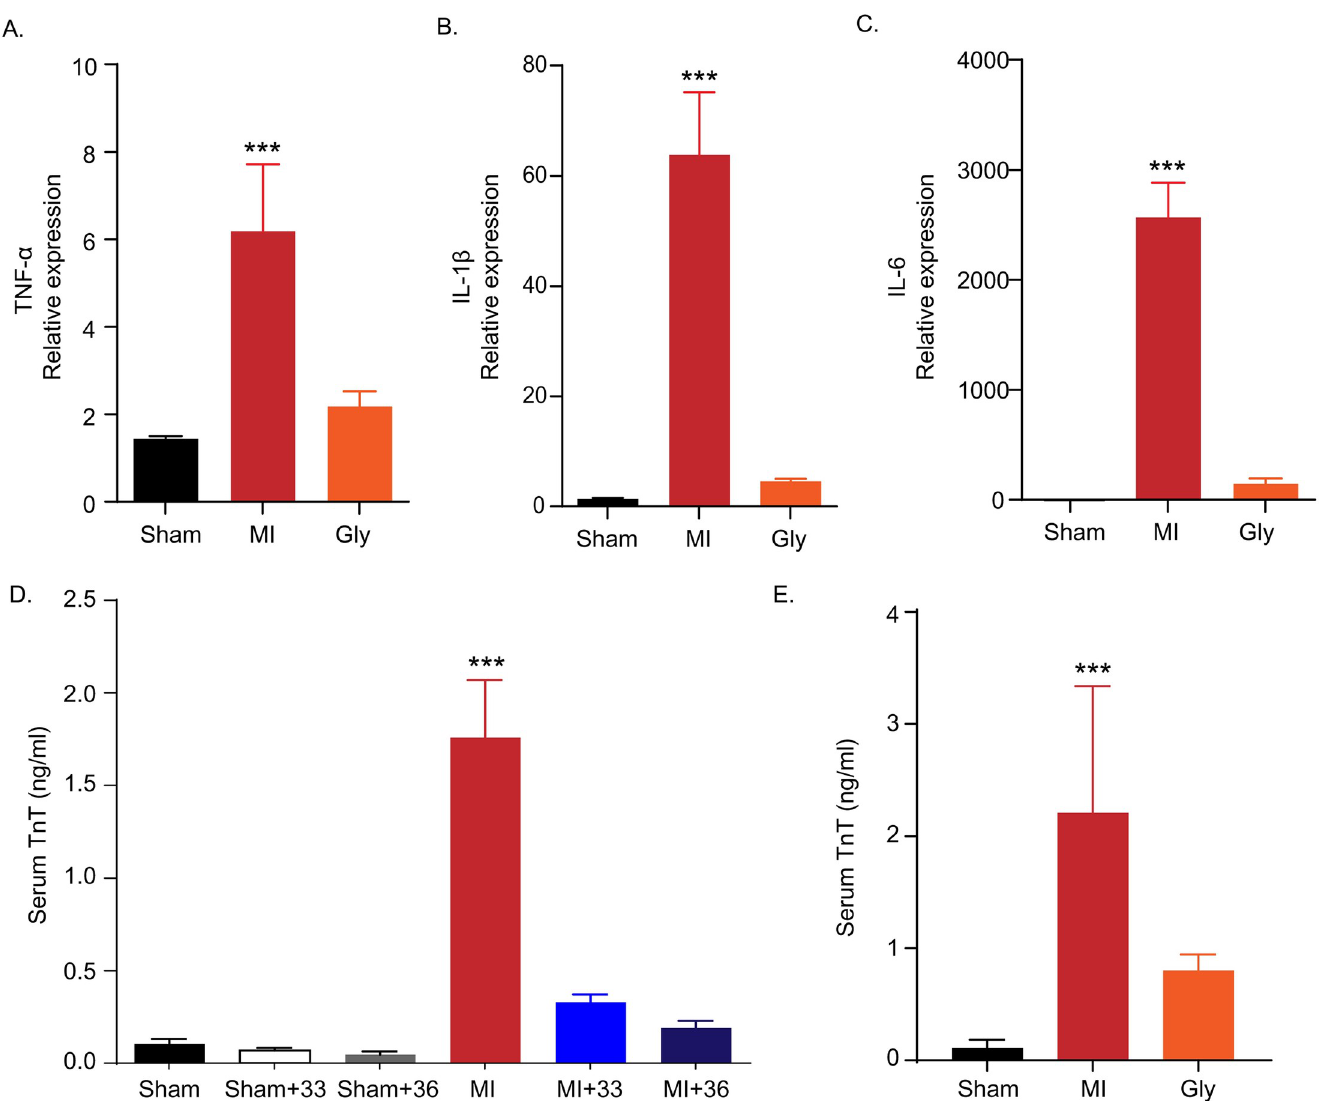
Fig 5. Inflammatory cytokine expression in myocardial I/R injury with and without glycyrrhizin treatment and levels of cardiac troponin T (cTnT) in plasma. A. Quantification of tumour necrosis factor- α (TNF- α ) expression by RT-PCR comparing myocardial I/R injury with and without glycyrrhizin treatment (the number of animals: n = 5, respectively), ��� P < 0.001, comparing myocardial I/R injury with and without glycyrrhizin by one-way analysis of variance (ANOVA) followed by Bonferroni post hoc test B. Quantification of interleukin-1 β (IL-1 β ) expression by RT-PCR comparing myocardial I/R injury with and without glycyrrhizin (the number of animals: n = 5, respectively), ��� P < 0.001, comparing myocardial I/R injury with and without glycyrrhizin treatment by one-way ANOVA followed by Bonferroni post hoc test C. Quantification of interleukin-6 (IL-6) expression by RT-PCR comparing myocardial I/R injury with and without glycyrrhizin treatment (the number of animals: n = 5, respectively), ��� P < 0.001, comparing myocardial I/R injury with and without glycyrrhizin treatment by one-way ANOVA followed by Bonferroni post hoc test. D. Quantification of serum TnT level by ELISA comparing myocardial I/R with normothermia and hypothermia (33˚C and 36˚C) (number of animals: n = 5), ��� P < 0.001, comparison of myocardial I/R with normothermia and hypothermia (33˚C and 36˚C) by one-way analysis of variance (ANOVA) followed by Bonferroni post hoc test. E. Quantification of serum TnT level by ELISA with comparing myocardial I/R injury with and without glycyrrhizin pre- treatment (number of animals: n = 5), ��� P < 0.001, comparing myocardial I/R injury with and without glycyrrhizin pre-treatment by one-way ANOVA followed by Bonferroni post hoc